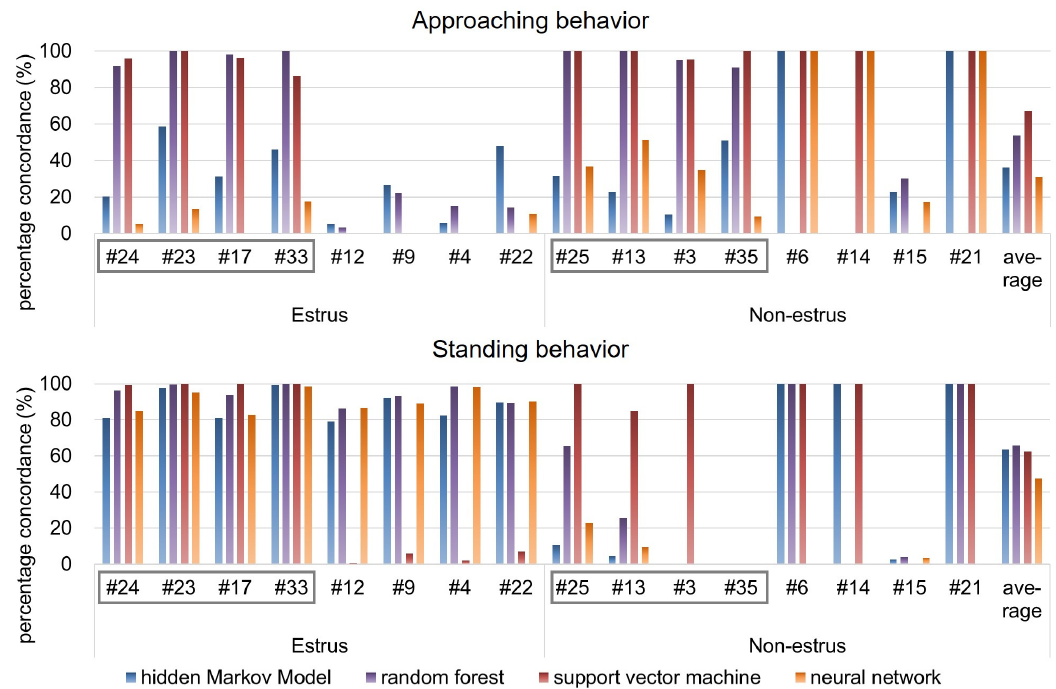
Figure 5. PC of each goat and average PC of all goats using various machine learning methods. Gray-colored frames represent goats used for training